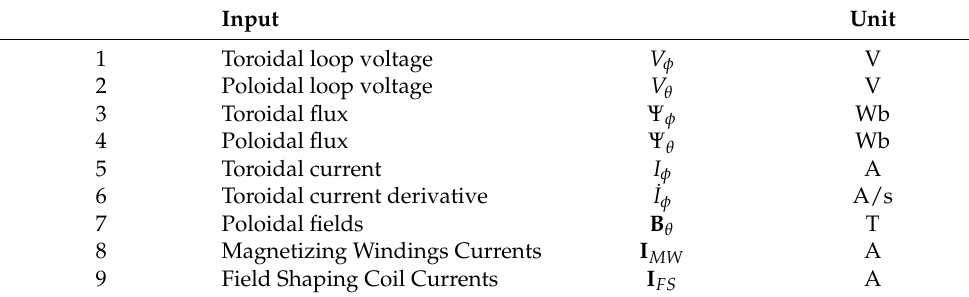
Table 1. List of the inputs to the axisymmetric system.